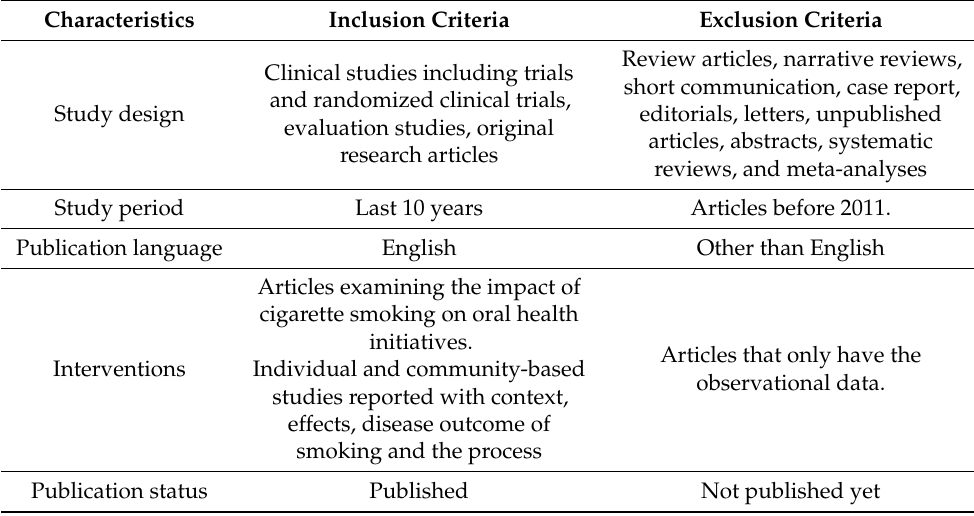
Table 2. Criteria for inclusion and exclusion of research